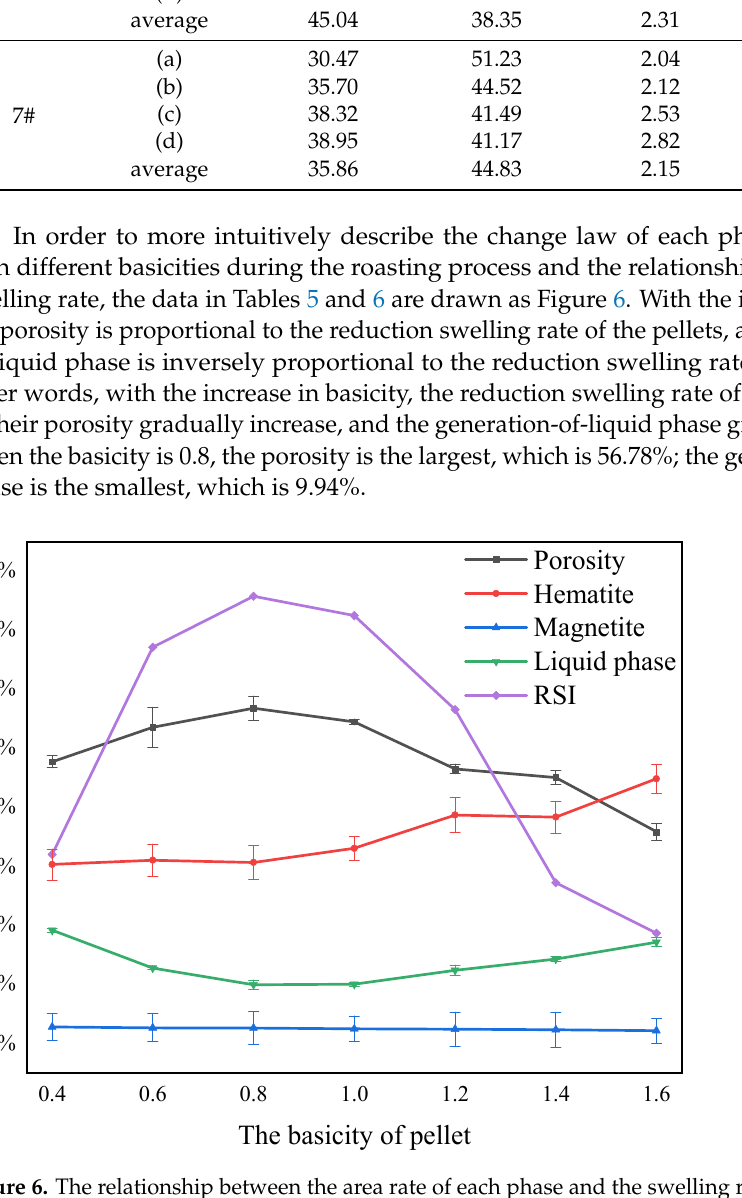
Figure 6. The relationship between the area rate of each phase and the swelling rate of pellet samples with different basicities .